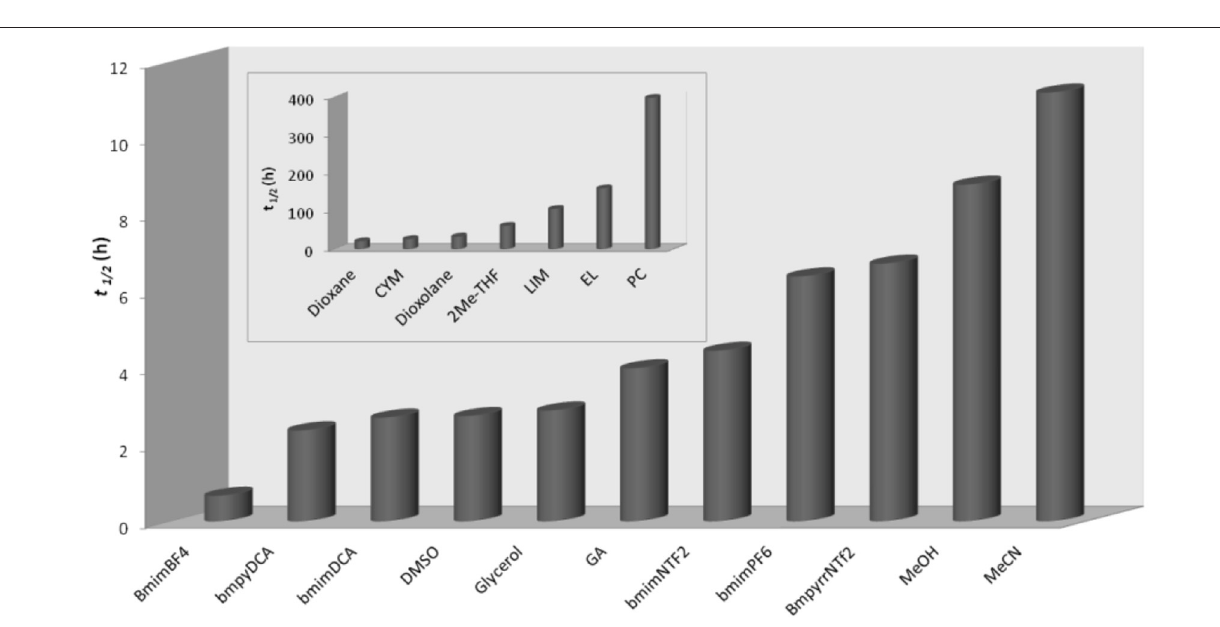
Frontiers in Chemistry |